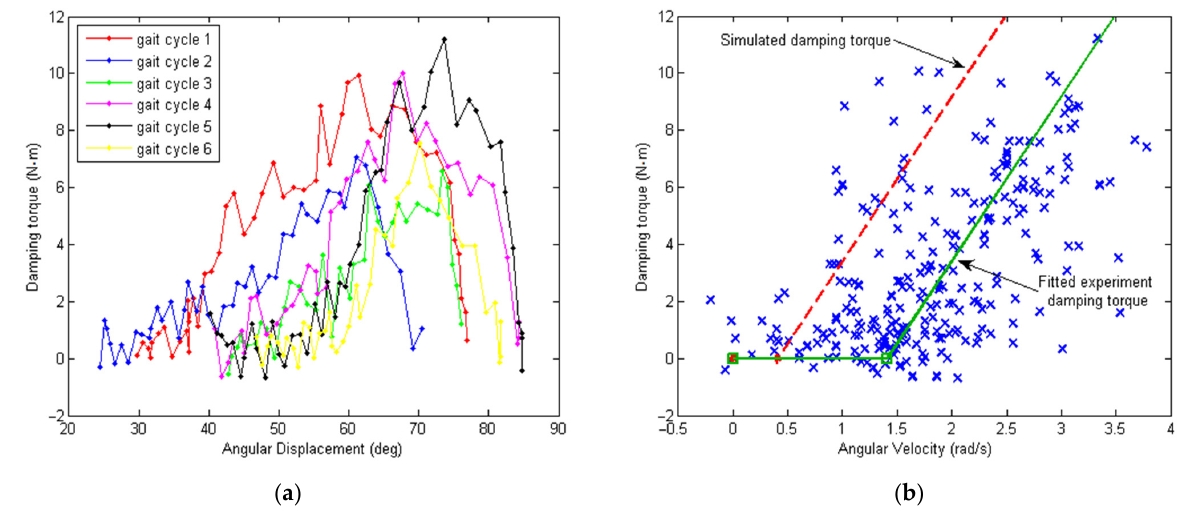
Figure 16. Plots of estimated damping torque based on measured generator current. Only the gait phases with energy harvesting are shown. ( a ) Experimental damping torque τ gCDamping (with capacitor load) as the angular displacement of the knee joint θ k changes. The six gait cycles correspond to those in Figure 1. ( b ) Experimental damping torque τ gCDamping (with capacitor load) as the angular velocity of the knee joint θ k changes. Acomparison of the EMG thigh muscle activity with and without the energy har- vesting control is presented in Figure 17. The EMG signals here were rectified and low-pass filtered for better presentation of the thigh muscle activities, as shown in Fig- ure 17a. The box plots of the EMG signals are plotted in Figure 17b, where a reduction of 7.91% for the median EMG signal was observed when there was energy harvesting.